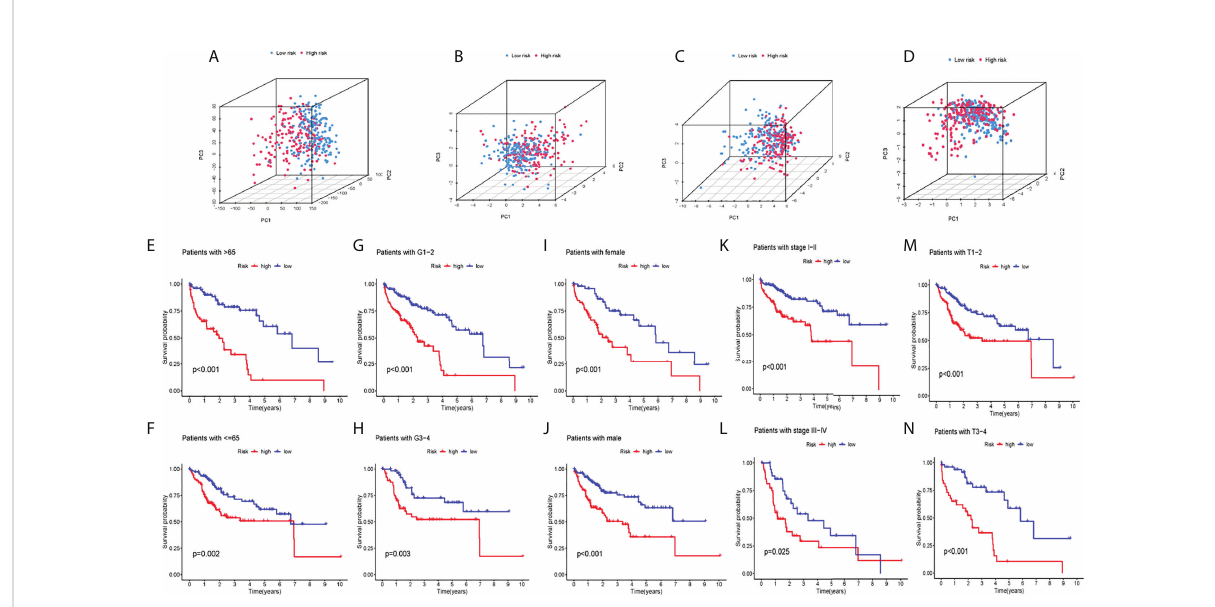
FIGURE 3 PCA analysis and systematic evaluation of CRLs and clinical parameters in HCC patients. (A) allGene PCA analysis; (B) cuproptosisLncRNA PCA analysis; (C) cuproptosisGene PCA analysis; (D) riskLnc PCA analysis; (E – N) Survival analyses of the risk score in different subgroups of various clinical factors: age ( ≤ />65years), pathological grade (1 – 2/3 – 4), sex (female/male),clinical stage (I – II/III – IV) and pathological